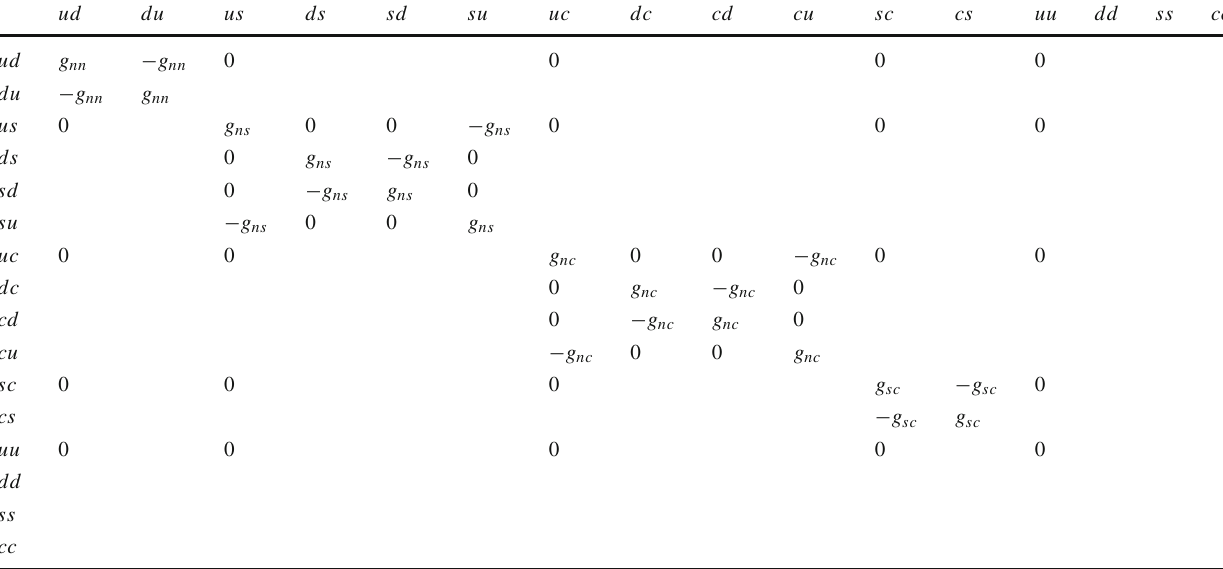
Table 1 Matrix elements of flavor-dependent coupling strength operators ˆ g qq flavor